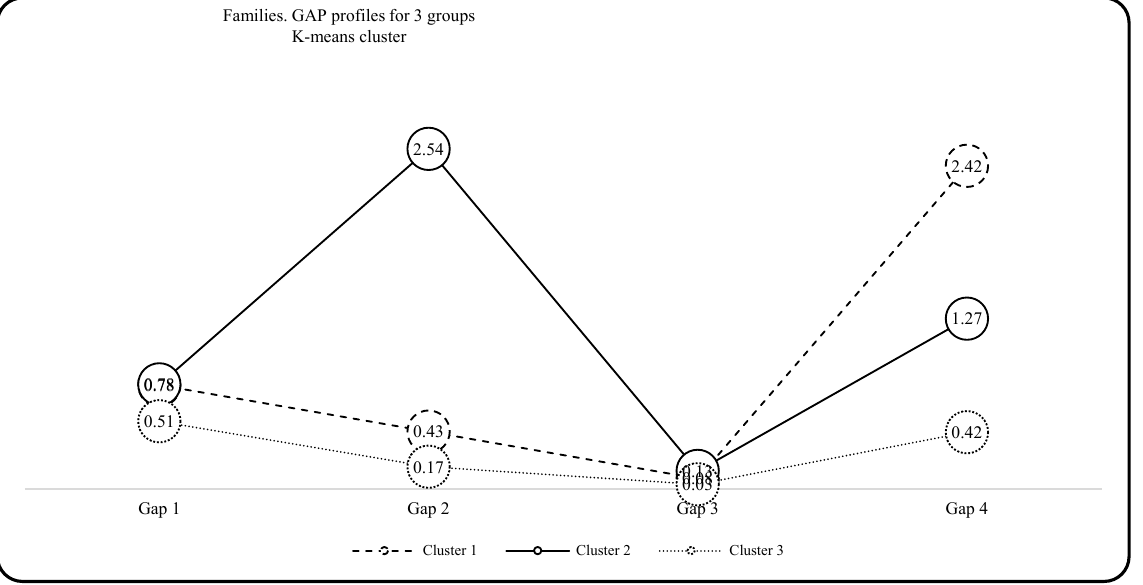
Figure 3. Gap profiles for three groups per k-means cluster.